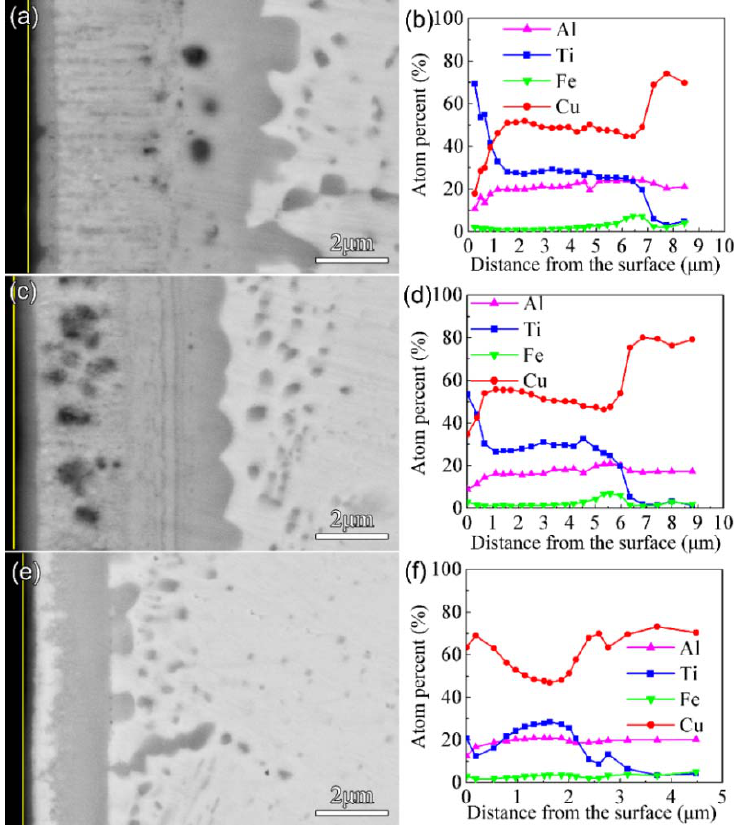
Figure 5. Morphology of the cross-section (back-scattered electron image) and EDS results for the Cu-Ti films after plasma nitriding at 650 °C for 4 h: ( a ) and ( b ) for F1, ( c ) and ( d ) for F2, ( e ) and ( f ) for F3.